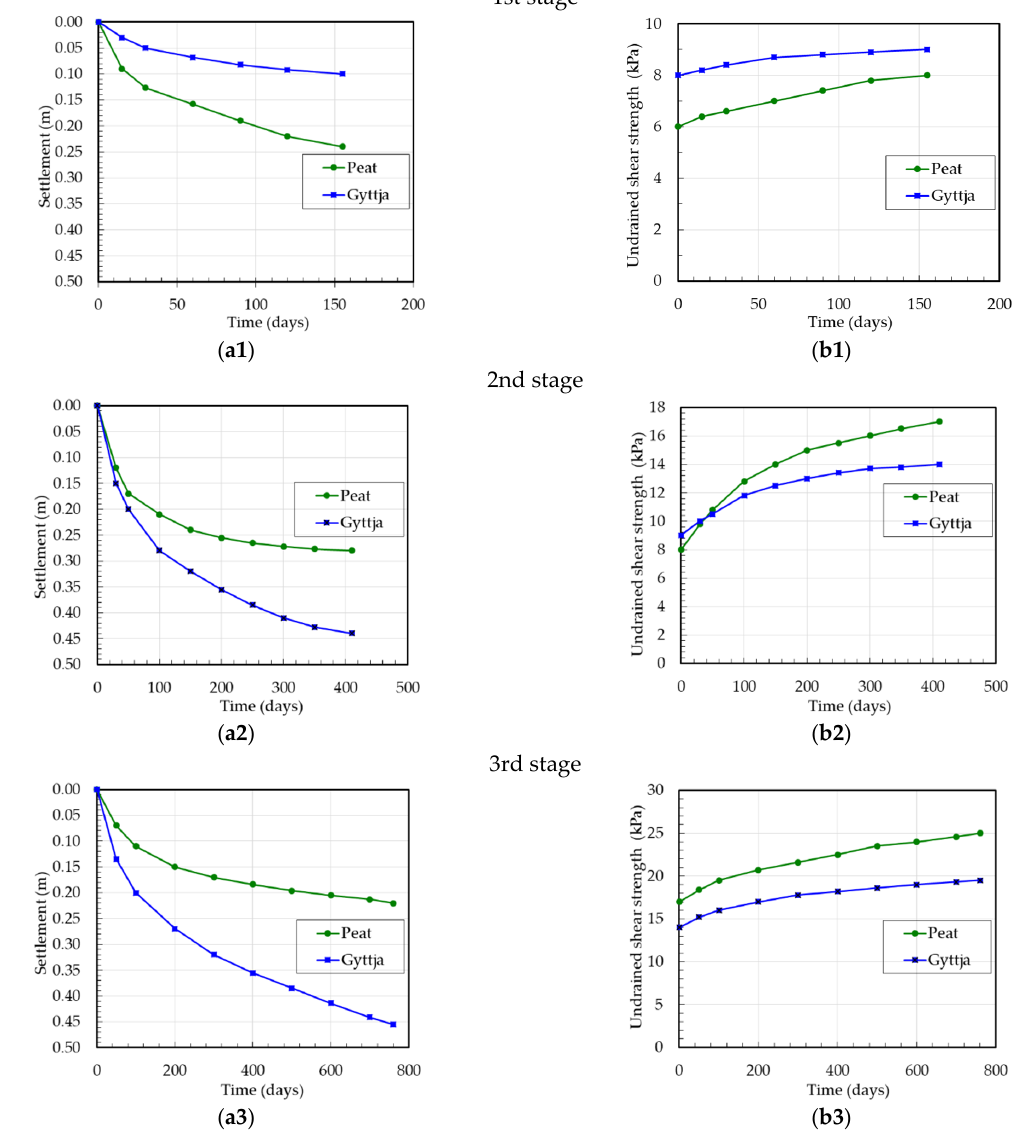
Figure 7. Test embankment at the Antoniny site: ( a1 – a3 ) settlement versus time, ( b1 – b3 ) undrained shear strength versus time.